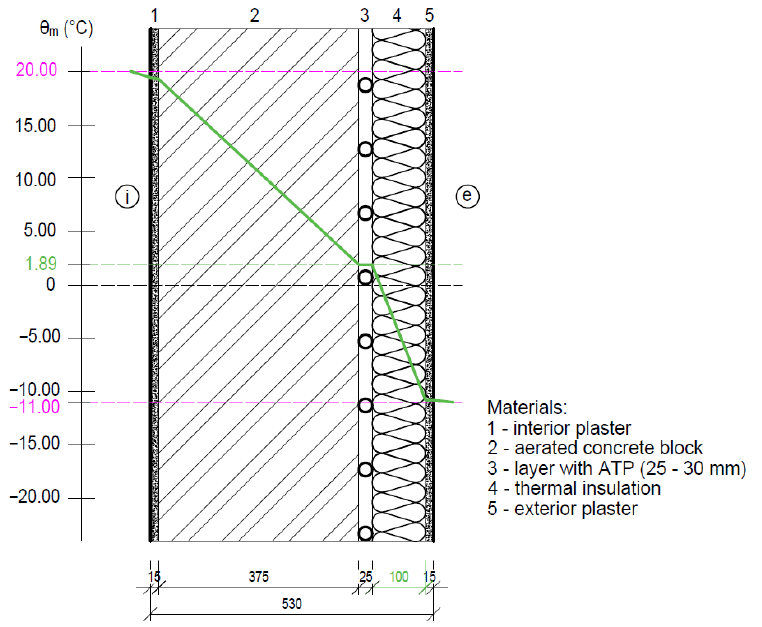
Figure 22. Fragment 3—wall with a load-bearing part made of aerated concrete blocks with a thick- ness of 375 mm and thermal insulation on the outside with a thickness of 100 mm. θ m —temperature in construction (°C), e—exterior, and i—interior.